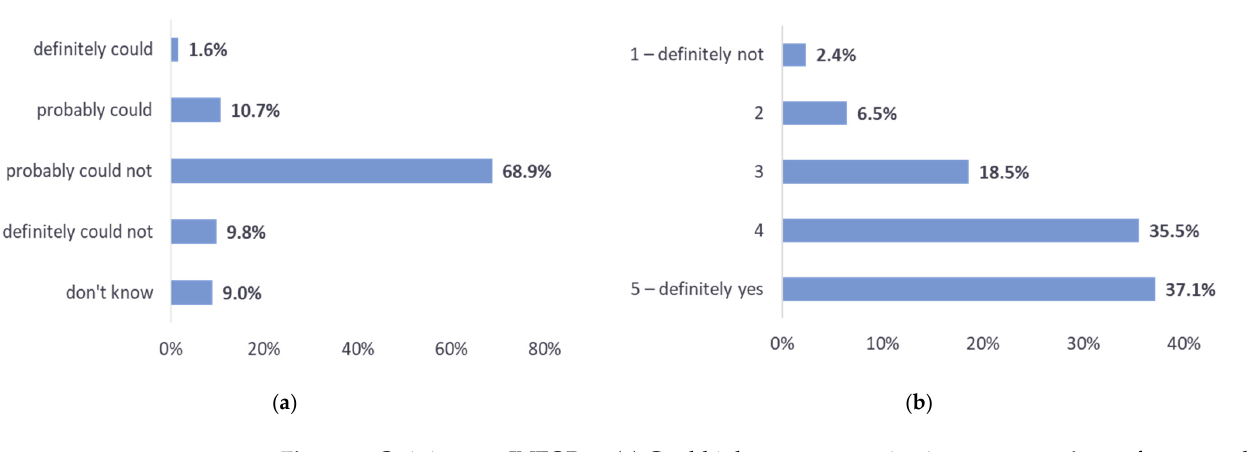
Figure 6. Opinions on INFOBot. ( a ) Could it have any negative impact on one’s comfort at work? ( b ) Would one be open to having it in one’s company?